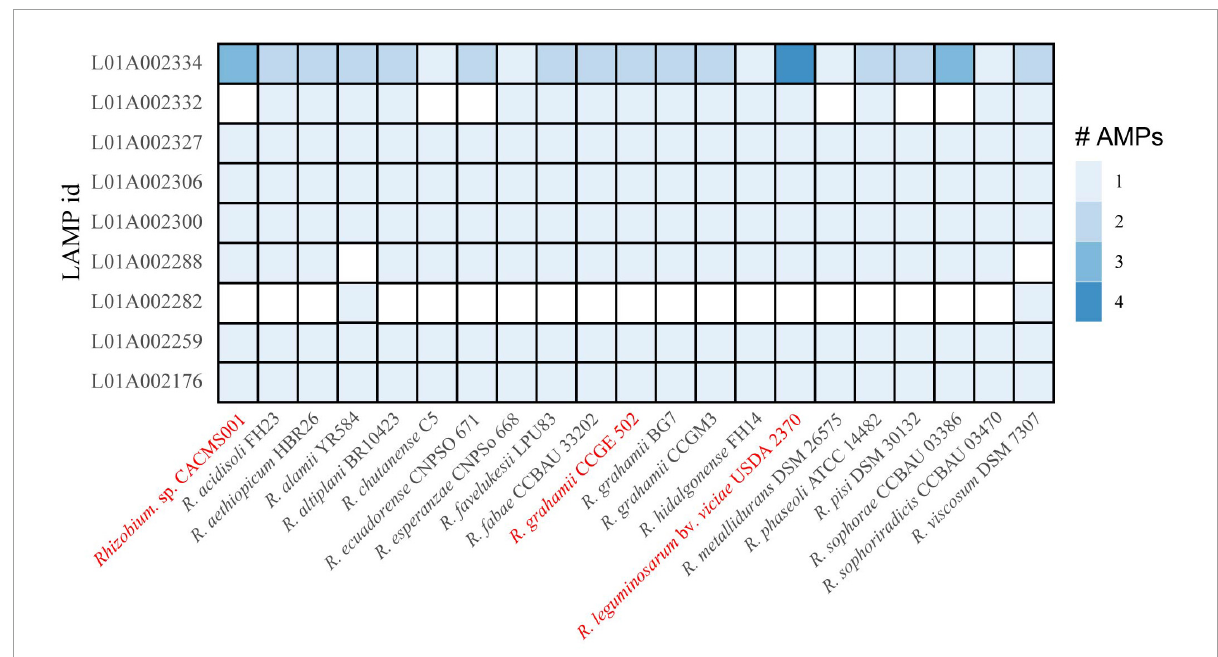
FIGURE7 AMP in Rhizobium species. Red words represent species whose effects on P. umbellatus and A. gallica have been